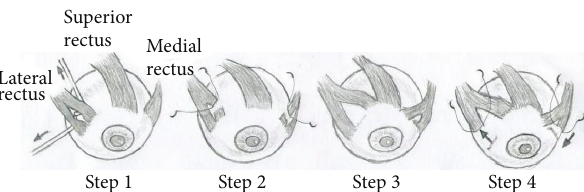
Figure 2: APRMT combined with horizontal muscle recession- resection (using paralysis of the superior rectus muscle as an example). Step 1: the medial rectus muscle and lateral rectus muscle were divided into 2 parts. Step 2: the upper one-half of the medial rectus muscle and lateral rectus muscle was shortened. Step 3: the shortened medial rectus muscle and lateral rectus muscle were transposedtotheinsertionofthesuperiorrectusmuscleonthenasal side and the temporal side. Step 4: recession-resection of the lower one-half of the medial rectus muscle and lateral rectus muscle was performed, and the ends of the recessed and resected muscles were aligned with the 2 original